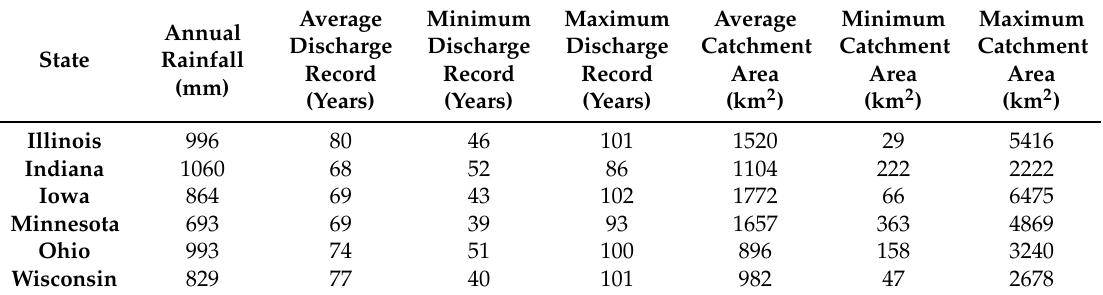
Table 2. Average Annual Precipitation, Discharge and Catchment Area Data for 25 rivers in each of the six states.